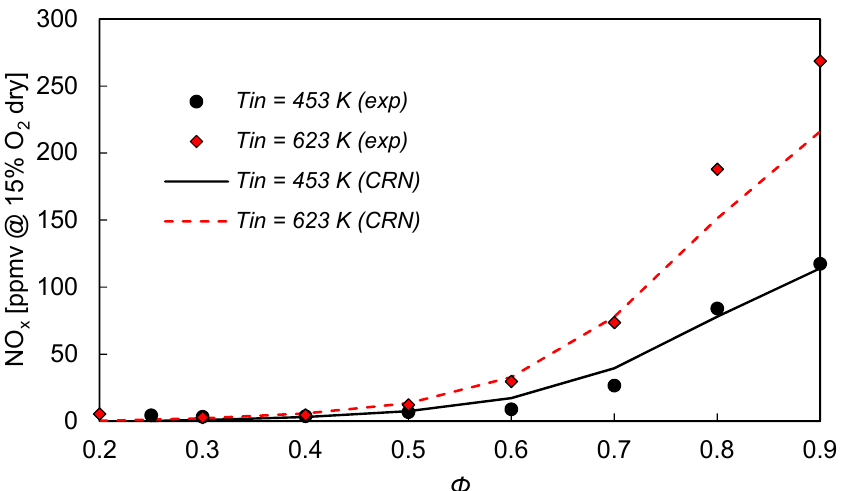
Figure 6. Comparison between experimental [33] and Chemical Reactor Network (CRN) NO x emissions results.